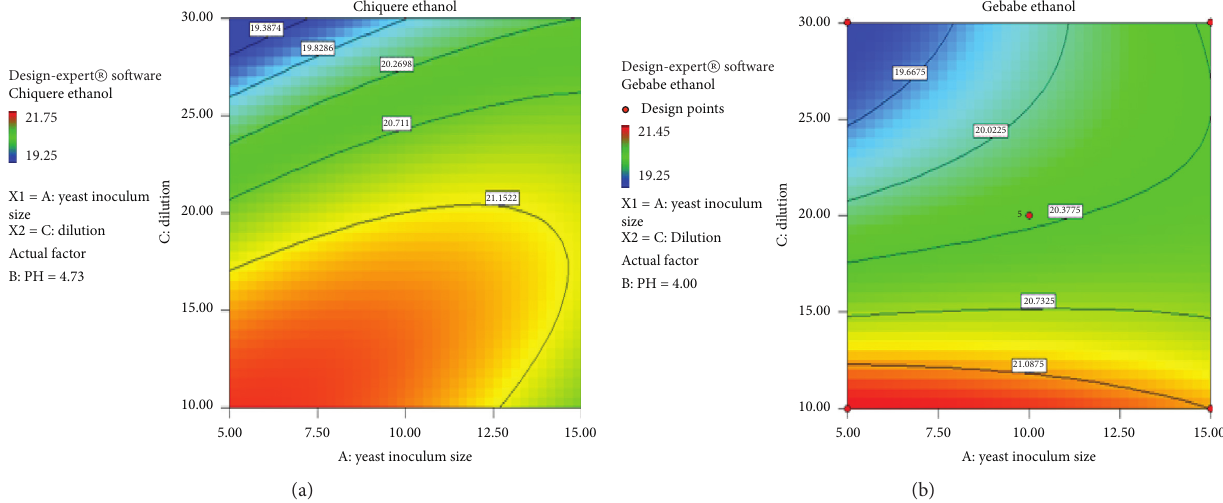
Figure 5: Contour plot for the effect of inoculum size and dilution factor on ethanol yield. (a) Chiquere variety; (b) Gebabe variety.